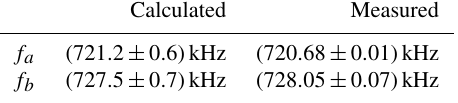
Table 3. Comparison of calculated and measured resonance fre- quencies f a and f b of the coupled system represented by the circuit in Fig. 4.